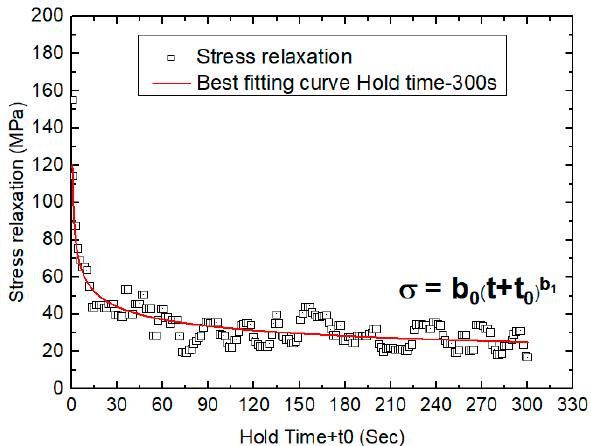
Figure 11. Power-law fit form to the stress relaxation part of Alloy 617 base metal during hold time.